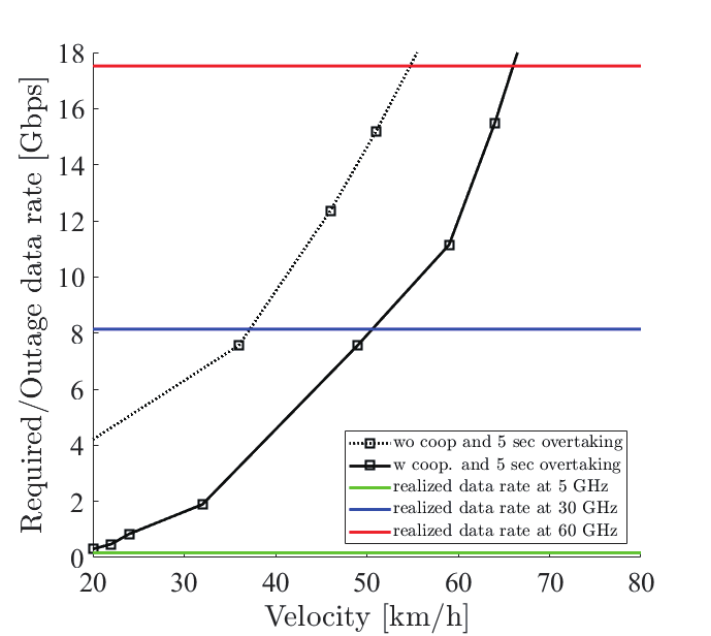
Figure 18. Required data rate and 0.01% outage data rate realized by the 5, 30 and 60 GHz bands under d be = 5 m.